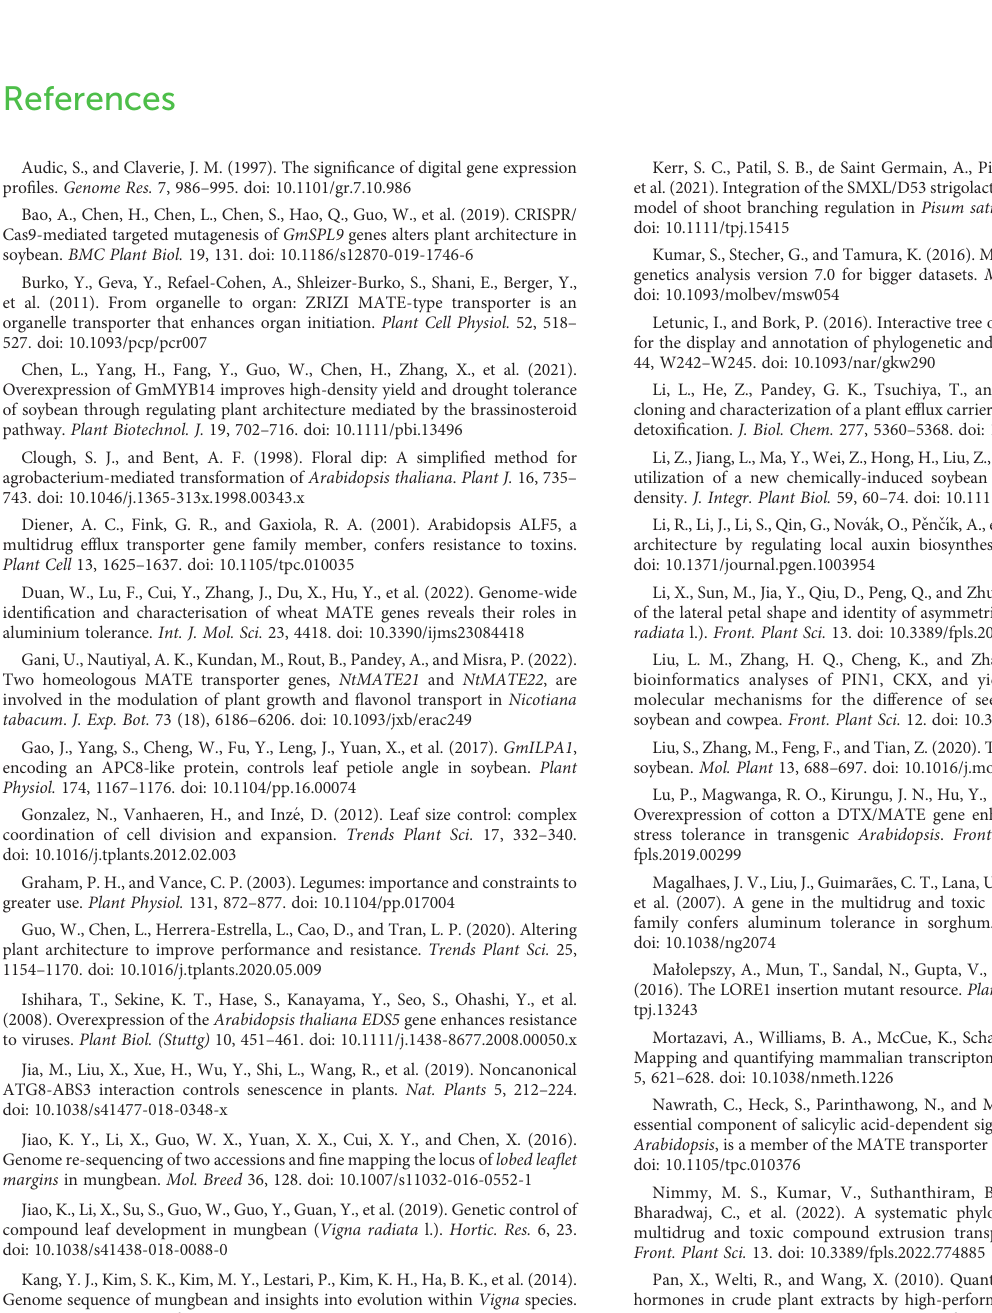
SUPPLEMENTARY TABLE 4 DEGs in young pods between WT and mib1